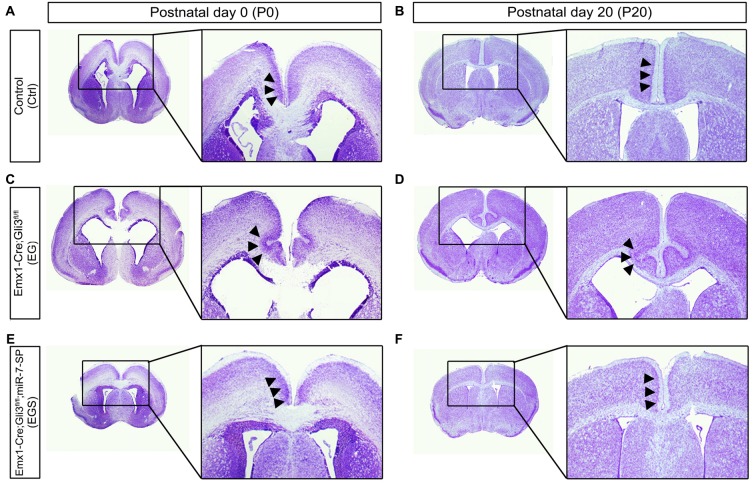
Gli3-deficiency induces abnormal morphogenesis in the cortical midline. (A,B) Normal-developing brains displayed smooth cortical surface at the midline of cortices at P0 and P20. (C,D) Cortices losing Gli3 showed in-folding phenotype at the midline of cortices at P0, and the defect is maintained at P20. (E,F) Conditionally blocking the function of miR-7 from the cerebral cortex corrected the mis-folding defect in the midline in the Gli3-deficient brain.